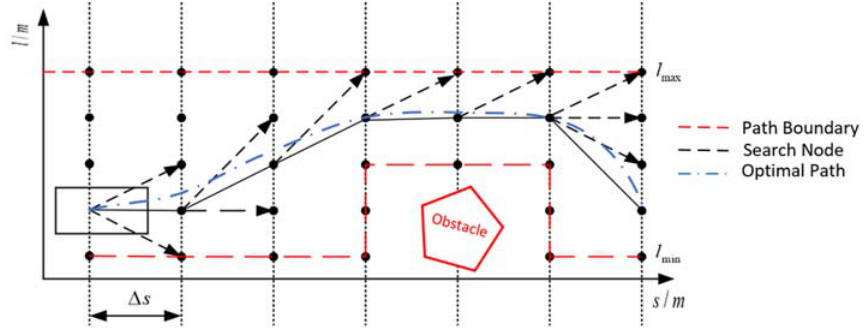
Figure 4. Multilayered Search Path Boundary in Lateral-Space graph.